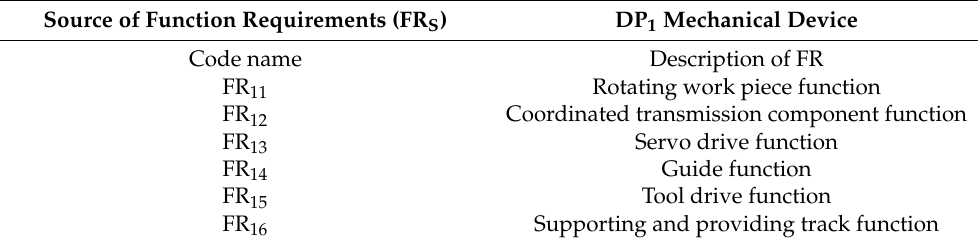
Figure 11. Schematic generation process diagram of FR 11 , FR 12 , FR 13 , FR 14 , FR 15 , and FR 16. Table 5. List of FR 11 , FR 12 , FR 13 , FR 14 , FR 15 , and FR 16 .